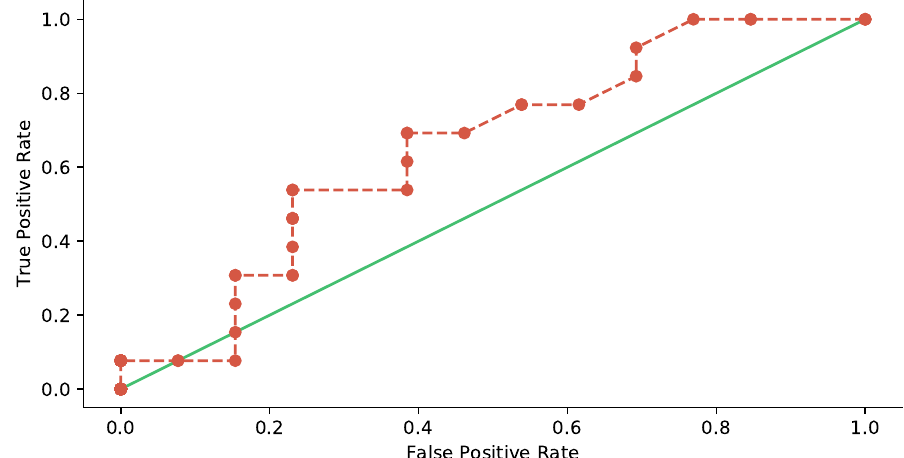
Figure 15. ROC Curves: Detecting Steganography via